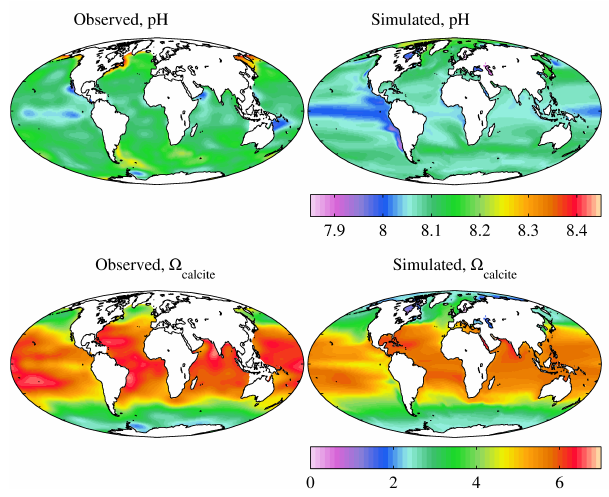
Fig. 19. Observational (GLODAP; left) and simulated (right) sur- face pH (top; –) and surface (cid:127) calcite (bottom;